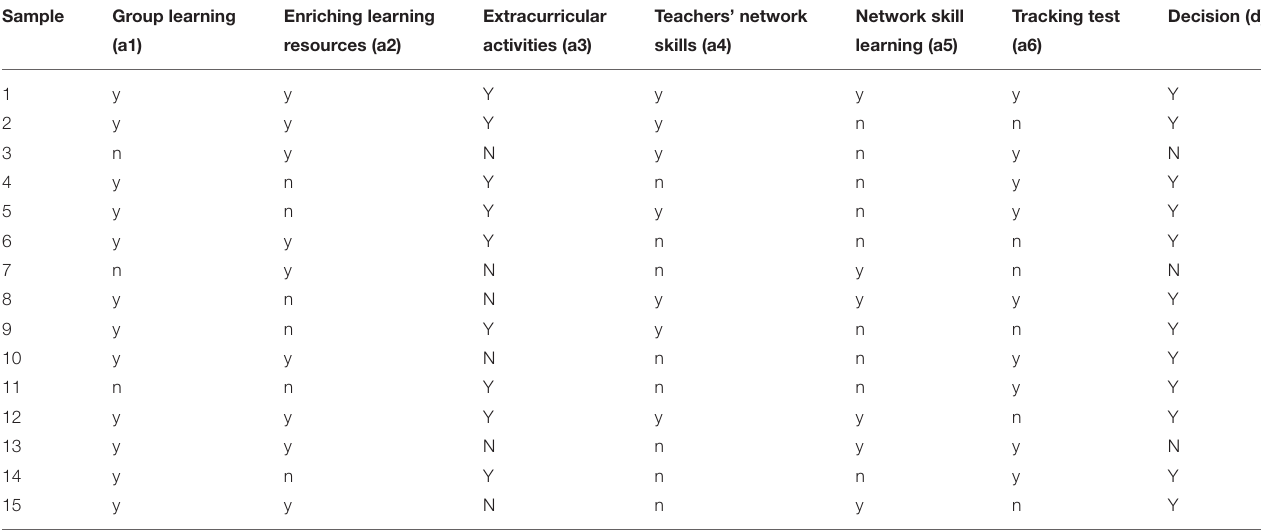
TABLE 3 | Decision data table of solutions optimization.